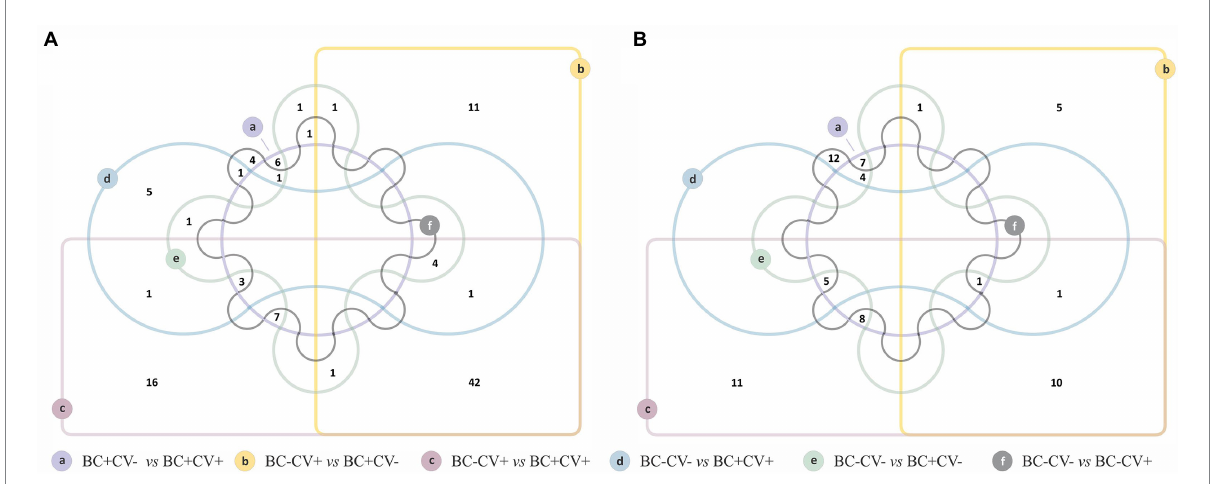
FIGURE 3 Edwards-Venn diagrams showing the number of bacterial taxa with significant differential relative abundance between each pairwise comparison of sample groups (CV + BC+, CV-BC+, CV + BC-, and CV-BC-). (A) Number of taxa overrepresented and shared between each comparison; (B) number of taxa underrepresented and shared between each